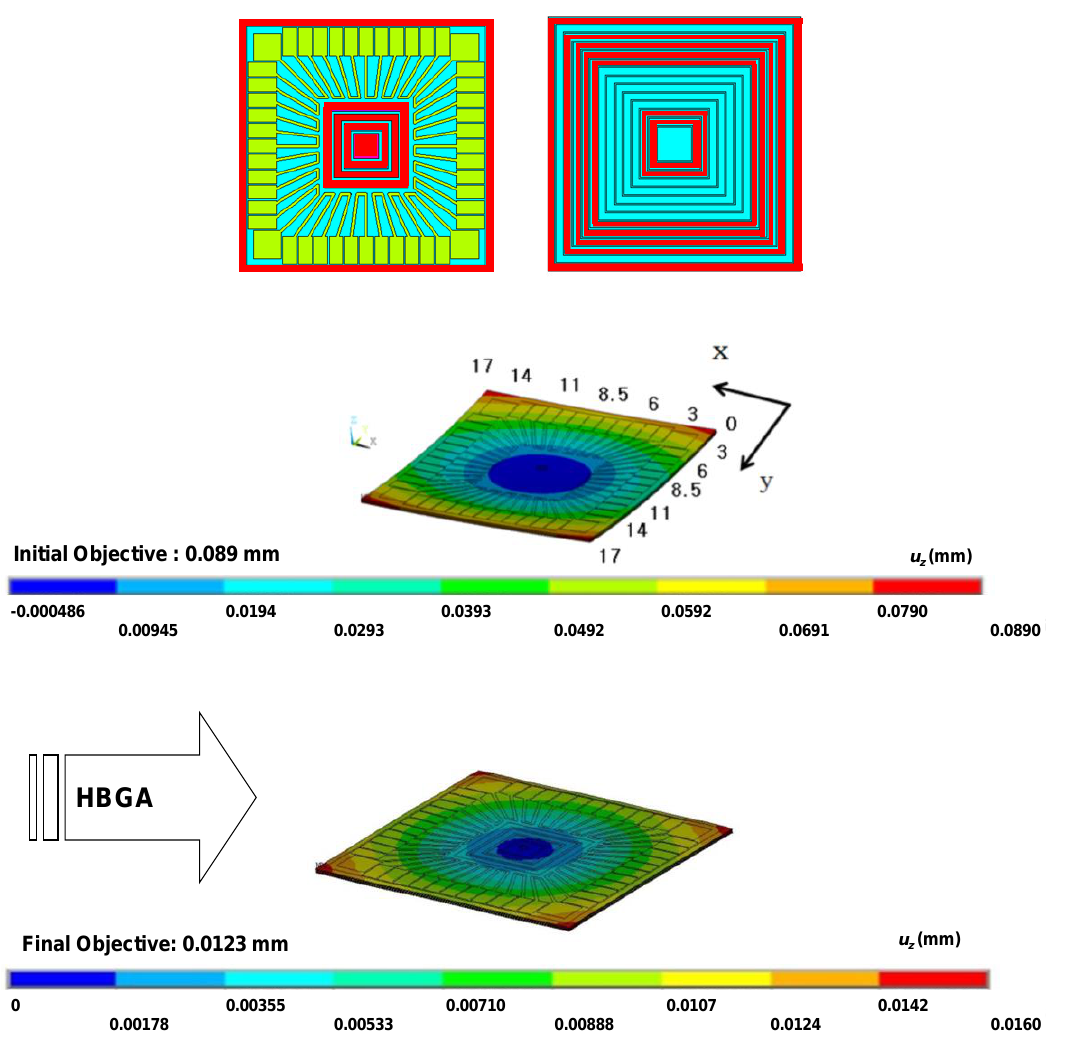
Figure 11. Optimized dummy pattern by the HBGA.